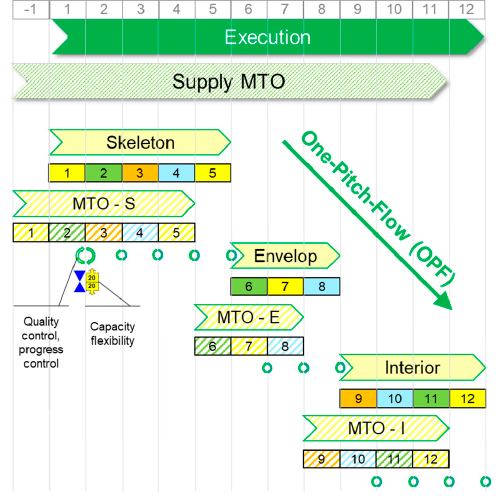
Figure 4. The One-Pitch-Flow approach for paced execution and supply.